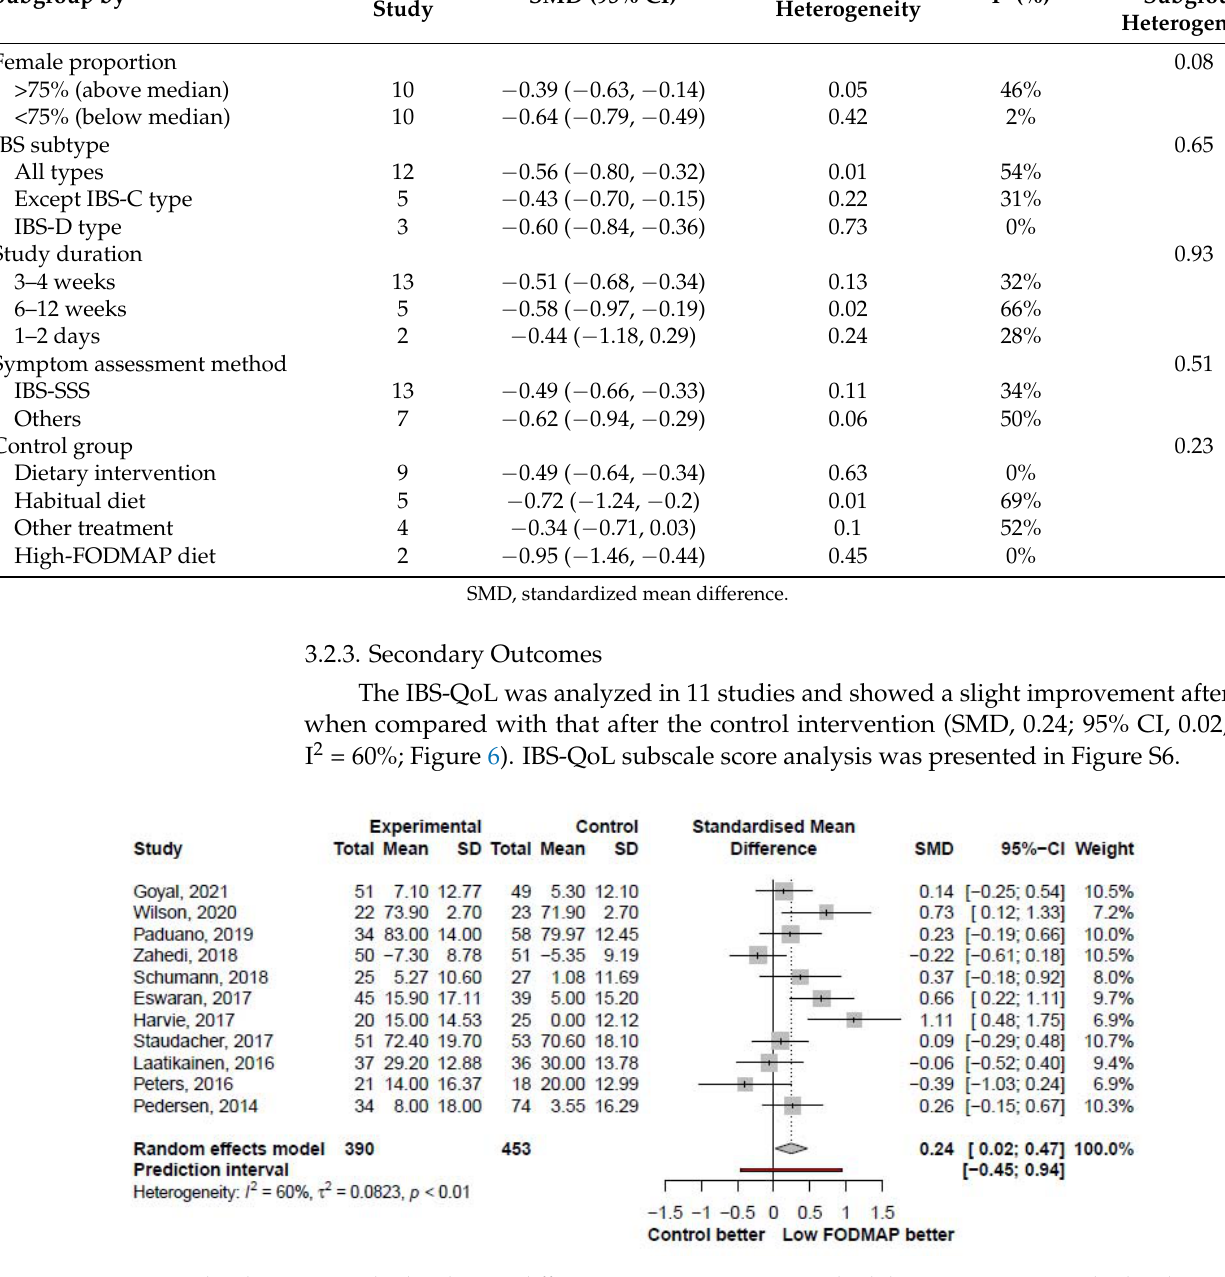
Figure 6. Forest plot showing standardized mean differences in IBS-QoL. SD, standard deviation; SMD, standardized mean difference; CI, confidence interval .